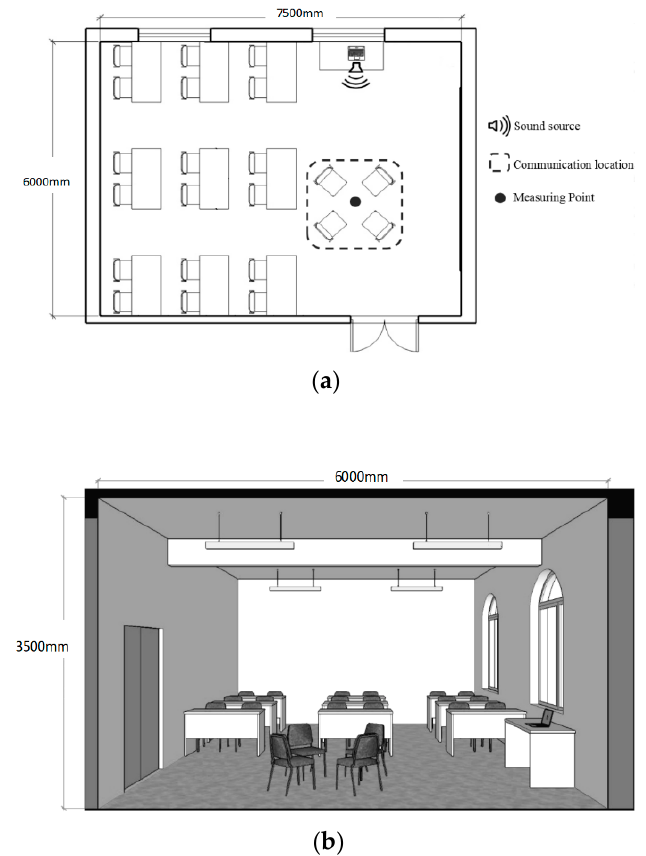
Figure 1. Indoor layout of the experimental room: ( a ) Plan of the experimental room ( b ) Selection of the experiment room.